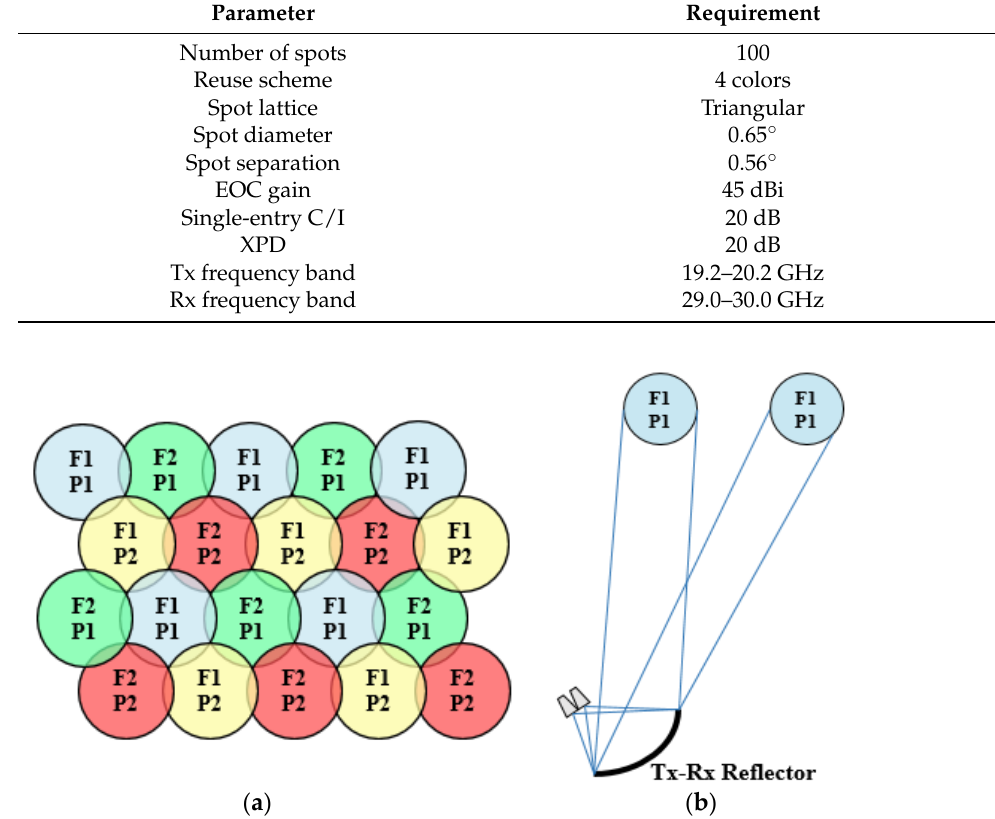
Figure 2. ( a ) Four-color multispot coverage required simultaneously in Tx and Rx. ( b ) Operating principle of current re- flectors used onboard the satellite, operating simultaneously in Tx and Rx. principle of current reflectors used onboard the satellite, operating simultaneously in Tx and